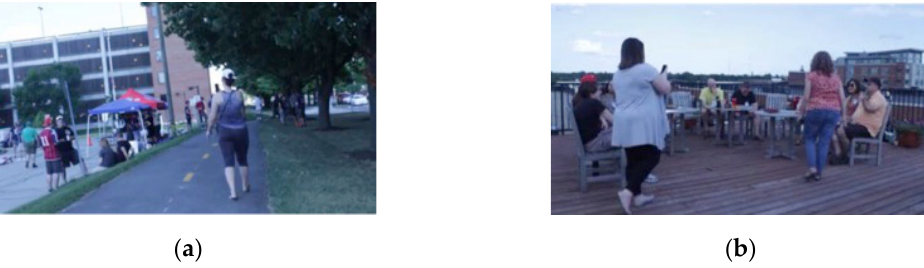
Figure 1. In each field study, a research confederate simulated the act of recording live-streaming video by holding her phone up in a vertical orientation and narrating the scene as if she were broadcasting to an unseen audience. Meanwhile, a second team member stood a distance away with a portable video camera to record bystanders’ reactions to the pantomimed live-stream. ( a ) A screencap from video of Public Context 1—“Sports Event”, in which only 15 of the 90 bystanders visibly reacted to the simulated mobile live-streaming in their vicinity, as indicated through glances, turning their heads or bodies toward the actions and overheard narration; ( b ) a screencap from video Event”, in which all 10 bystanders were seen visibly reacting to the pantomimed live-stream from of Public Context 2—“Meeting Event”, in which all 10 bystanders were seen visibly reacting to the confederate’s upheld pantomimed live-stream from confederate’s upheld smartphone.